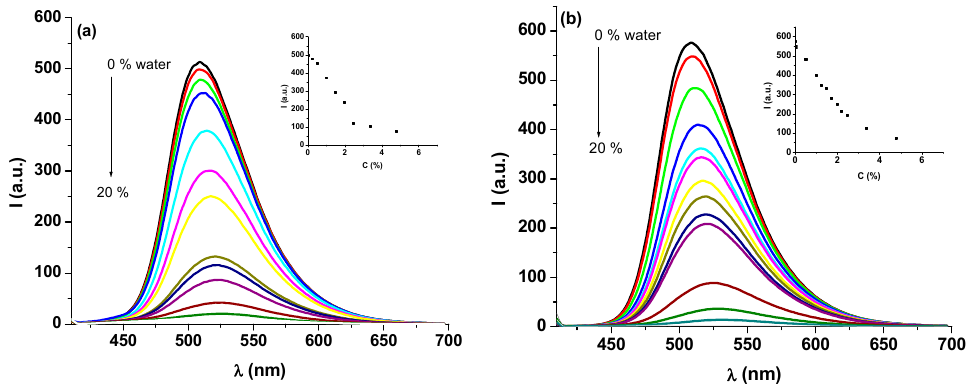
Figure 6. Fluorescence spectra in dioxane upon gradual addition of different amounts of water ( λ ex = 402 nm) for ( a ) 7 and ( b ) 8 . Insets present the linear dependence of emission intensity versus water level.